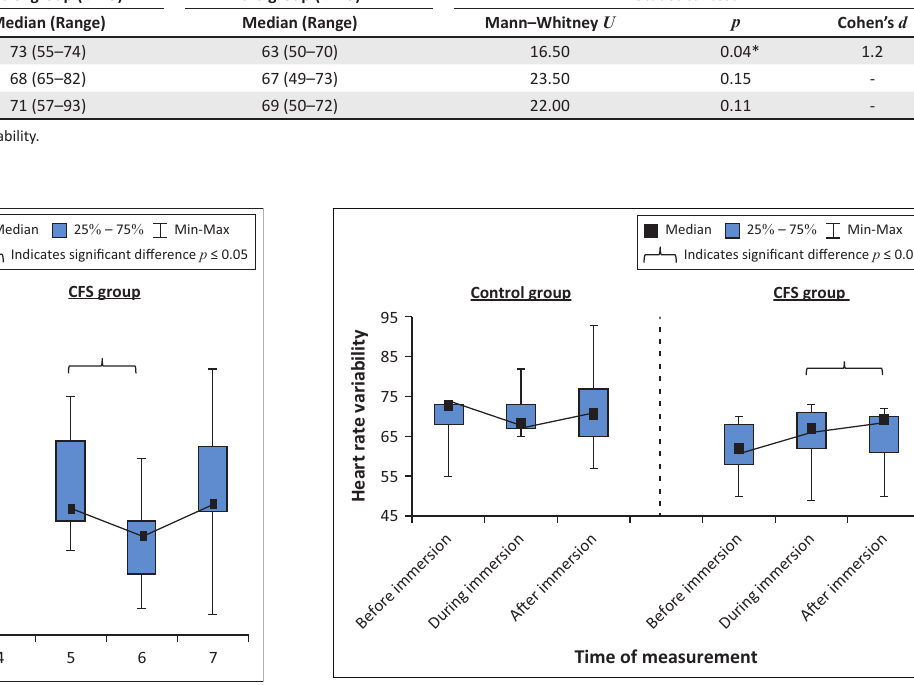
TABLE 3: Heart rate variability of the control and chronic fatigue syndrome groups before, during and after immersion ( N = 18).